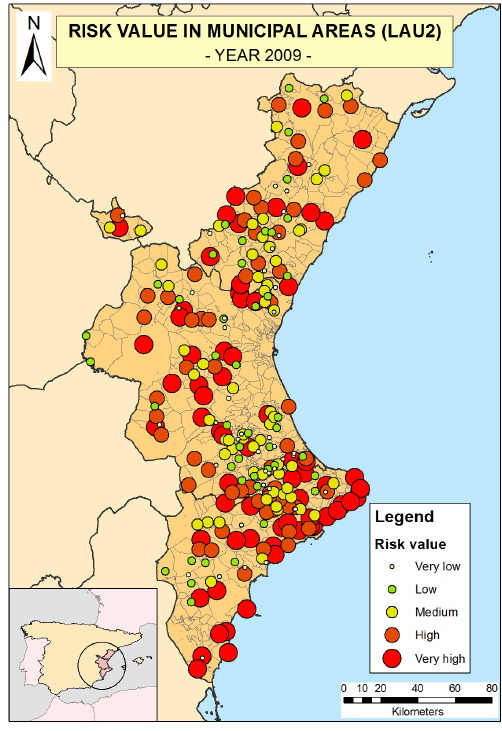
Figure 3. Location and quantification of risk value by municipality in the Valencia Community. Table 11. Surface area covered by dwellings, exposed elements and risk by